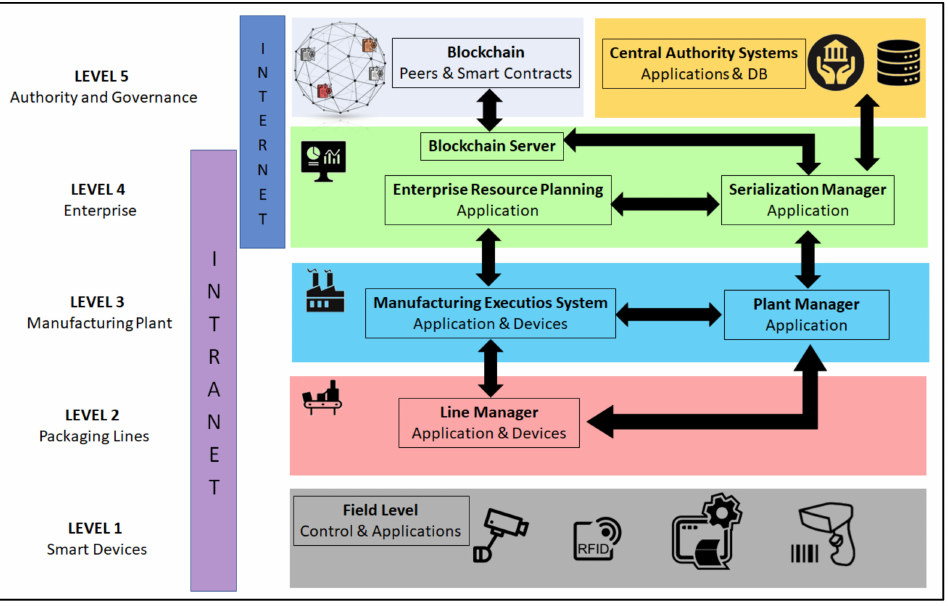
Figure 9. Architecture of the information system for the blockchain serialization with